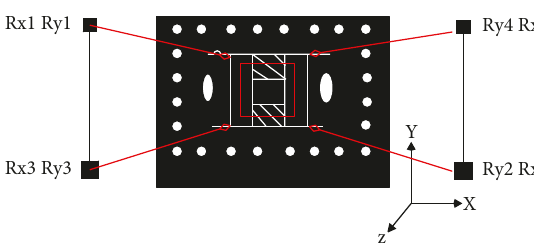
Figure 5: Schematic diagram of the x and y -axis structure of the acceleration sensor.